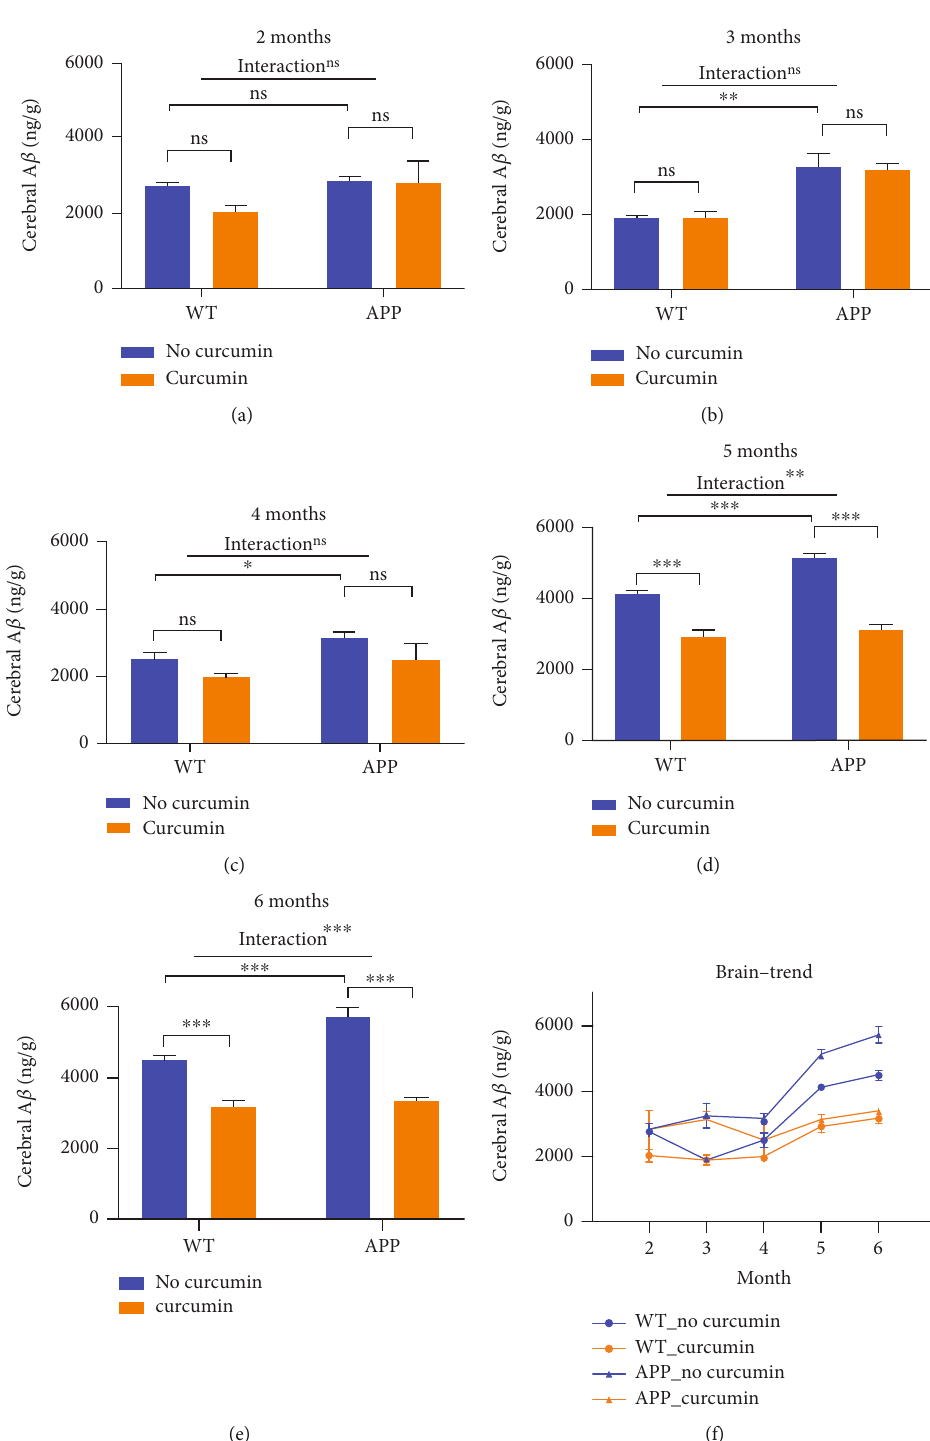
Figure 1: E ff ects of curcumin on the A β level in the cerebrum. Abbreviations: APP: APPswe/PS1dE9; WT: wild type; APP curcumin ( n = 19 ); APP : APP mice not given curcumin ( n = 17 ); WT N curcumin ( n = 17 ); ∗ P < 0 : 05 ; ∗∗ P < 0 : 01 ; ∗∗∗ P < 0 : 001